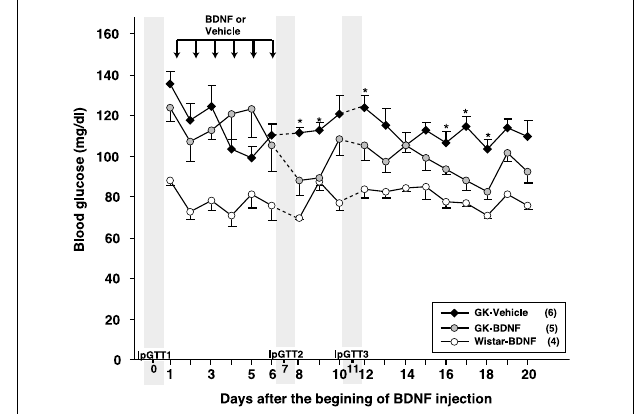
FIGURE 6 | Effect of BDNF treatment on casual blood glucose level in GK rats. Although BDNF did not alter blood glucose level during treatment, significant reduction of blood glucose level was observed after termination of BDNF treatment in GK-BDNF group ( ∗ p < 0 . 05 vs. other groups, One-Way ANOVA with Holm’s post-hoc